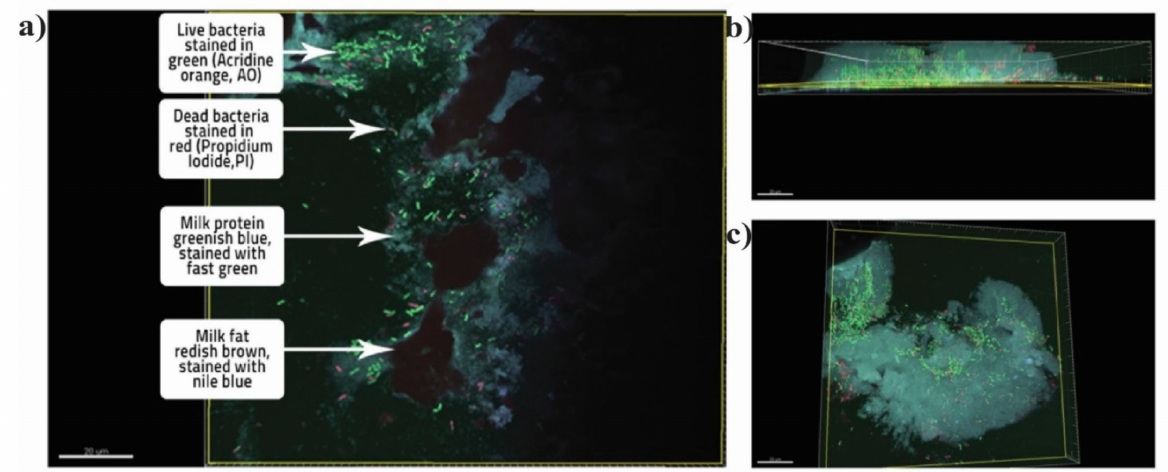
Figure 3. CLSM image of ( a ) surface of the WMP matrix, showing the immobilization of probiotic Lactobacillus paracasei within the fat and protein layers ( b ) cross section of the matrix, ( c ) spatial distribution of live and dead bacteria which are located below the surface, comprising of bacteria embedded in the protein and lactose matrix. Green live bacteria, red dead bacteria. The scale bar represents 20 µ